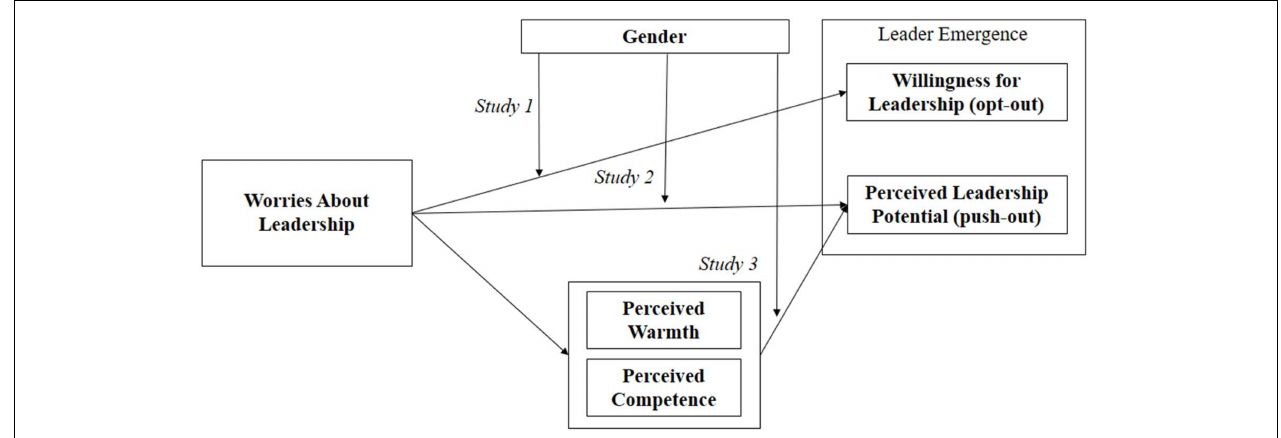
FIGURE 1 | Research